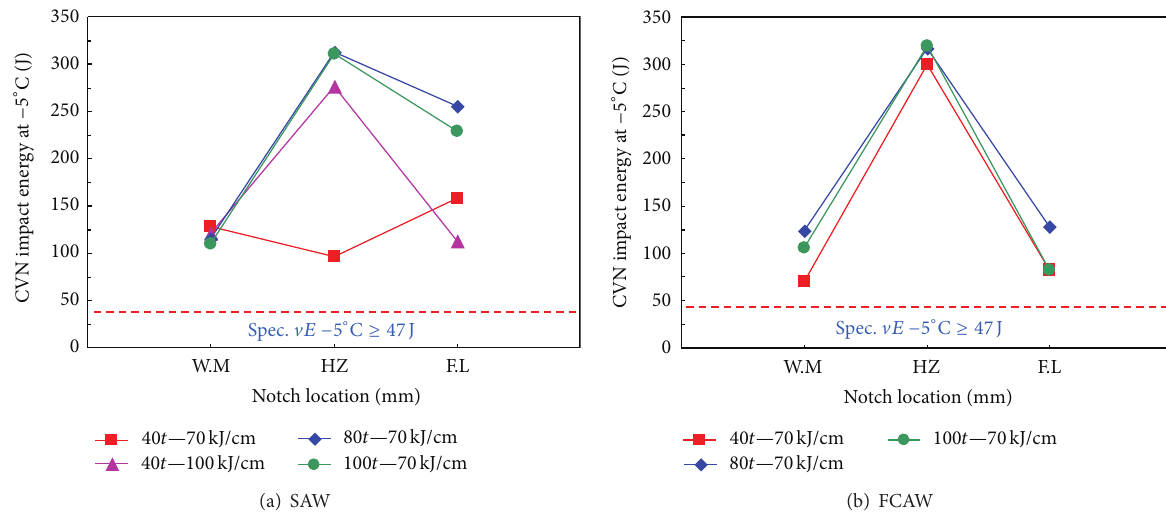
Figure 7: Impact test result of SM570TMCP welding